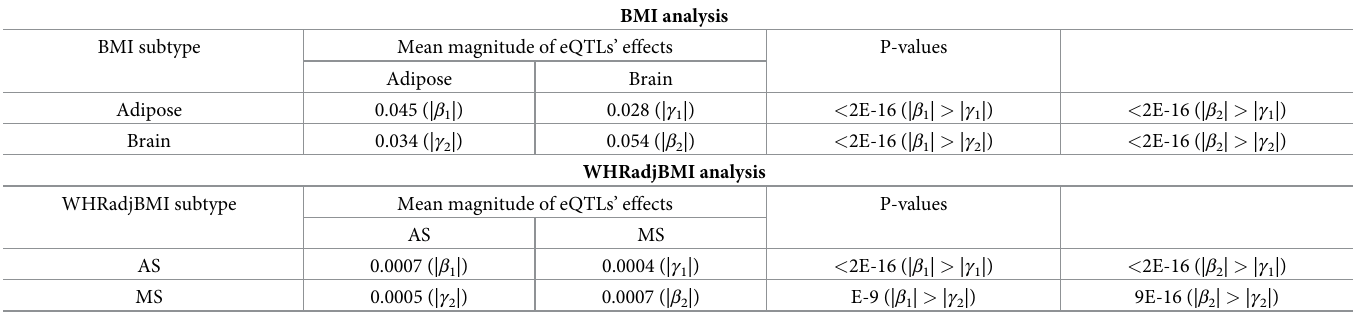
Table 1. Genetic heterogeneity between groups of individuals assigned to tissue-specific subtypes of BMI (or WHRadjBMI). In the BMI analysis, β 1 denotes the SNP- effect of an adipose eQTL on BMI in those individuals assigned to the adipose-specific subtype of BMI, β 2 is the SNP-effect of a brain eQTL on the brain-specific subtype of BMI, γ 1 is the SNP-effect of a brain eQTL on the adipose subtype and γ 2 is the effect of an adipose eQTL on the brain subtype. We provide the mean magnitude of the effect sizes of a tissue-specific eQTLs on the BMI of the corresponding tissue-specific group of individuals (e.g., joint SNP-effect of the adipose eQTLs on the BMI of indi- viduals with adipose subtype), and the p-values obtained from the Wilcoxon rank sum (WRS) right tail tests of effect heterogeneity. For each test, the alternative hypotheses are listed in parentheses, while the null hypothesis is the equality between the corresponding pair of parameters. These parameters are defined in the same way for the adi- pose subcutaneous (AS) and muscle skeletal (MS) tissue-specific subtype of WHRadjBMI and the same analyses are